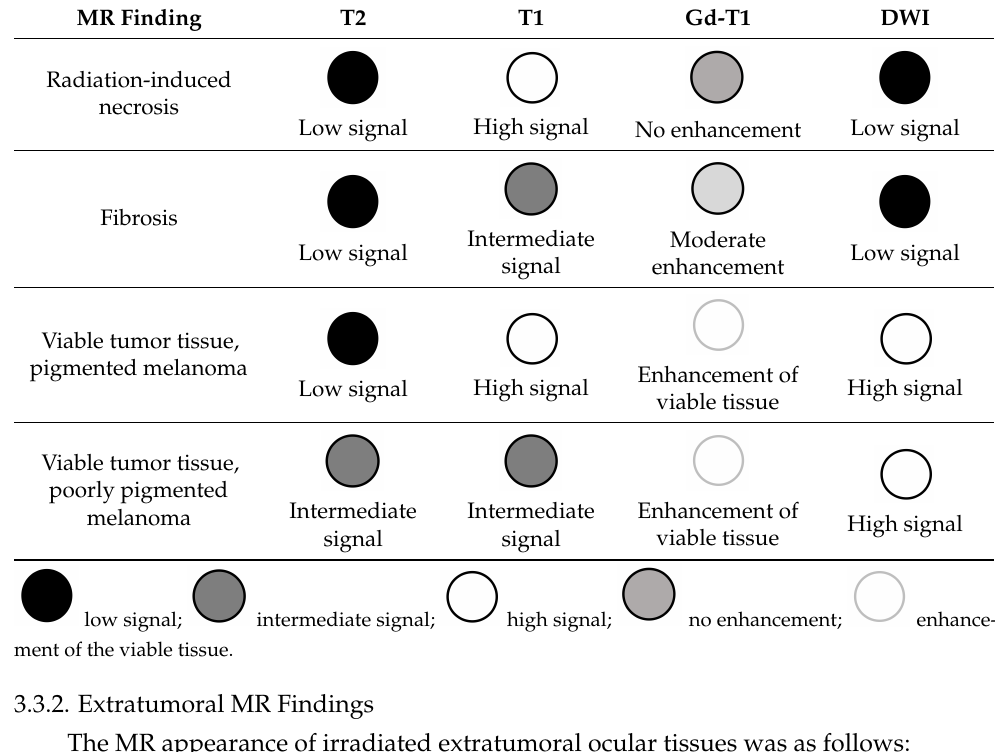
Table 5. Chart summarizing the MR imaging appearance of irradiated uveal